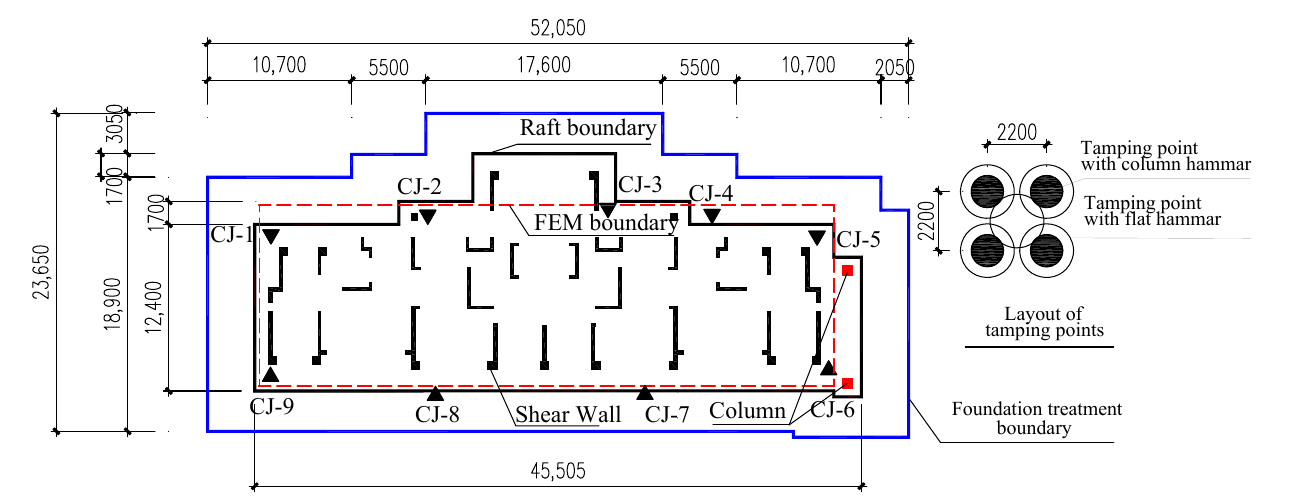
Figure 12. Shear wall and foundation plan layout of 15# building.